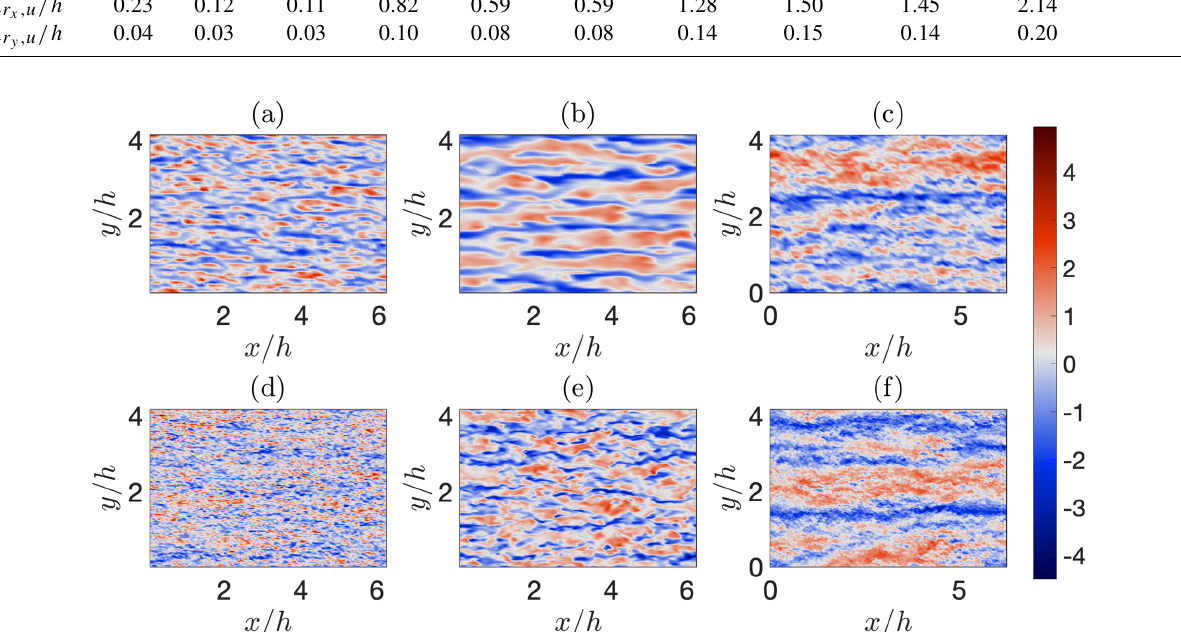
Figure 6. Instantaneous snapshots of normalized streamwise velocity fluctuations at z/h ≈ 0 . 1 from the simulations FV64 (a) , FV64* (b) , PSFD64 (c) , FV160 (d) , FV160* (e) , and PSFD160 (f) . The normalized velocity fluctuation is defined as (u −(cid:104) u (cid:105) xy )/u ∗ , where averages (and fluctuations therefrom) are evaluated in space over the selected horizontal